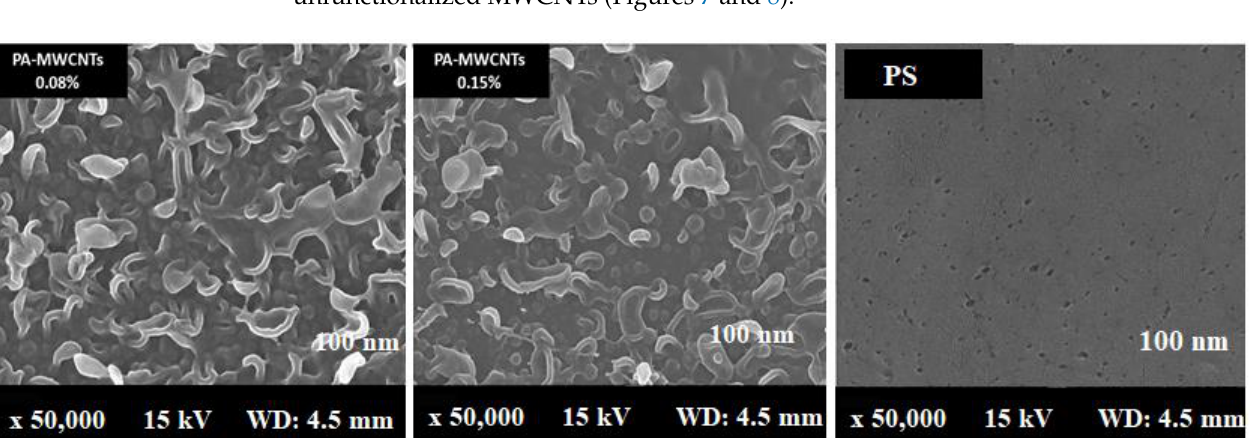
Figure 6. Zeta potentials of PA and PA and PA-EtOH (10%, 20%, and 30%) membranes as a function of pH.